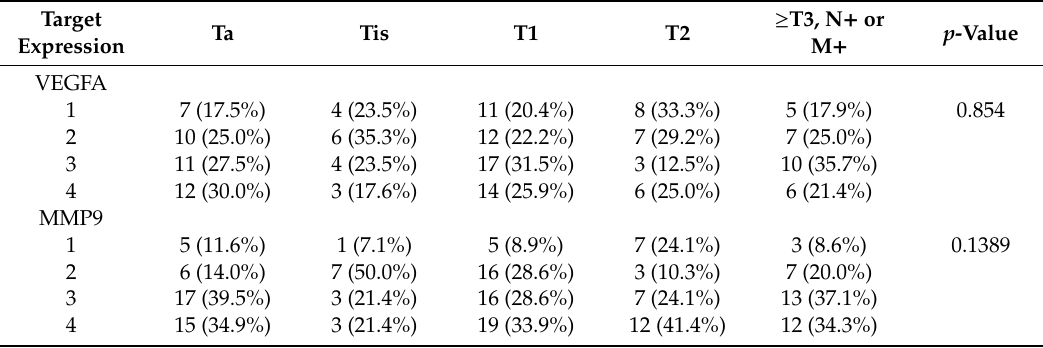
Table 4. Relationship between immunochemical features and tumor